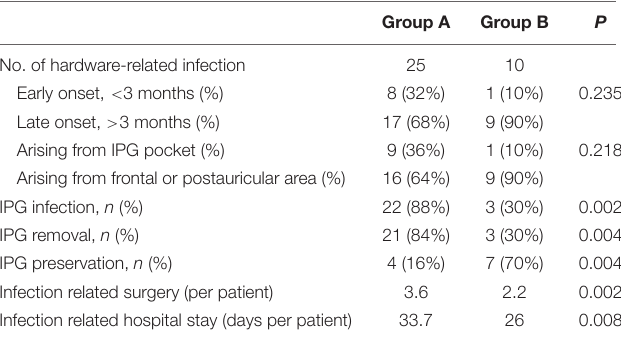
TABLE 2 | Statistical analysis of infection in group A and group